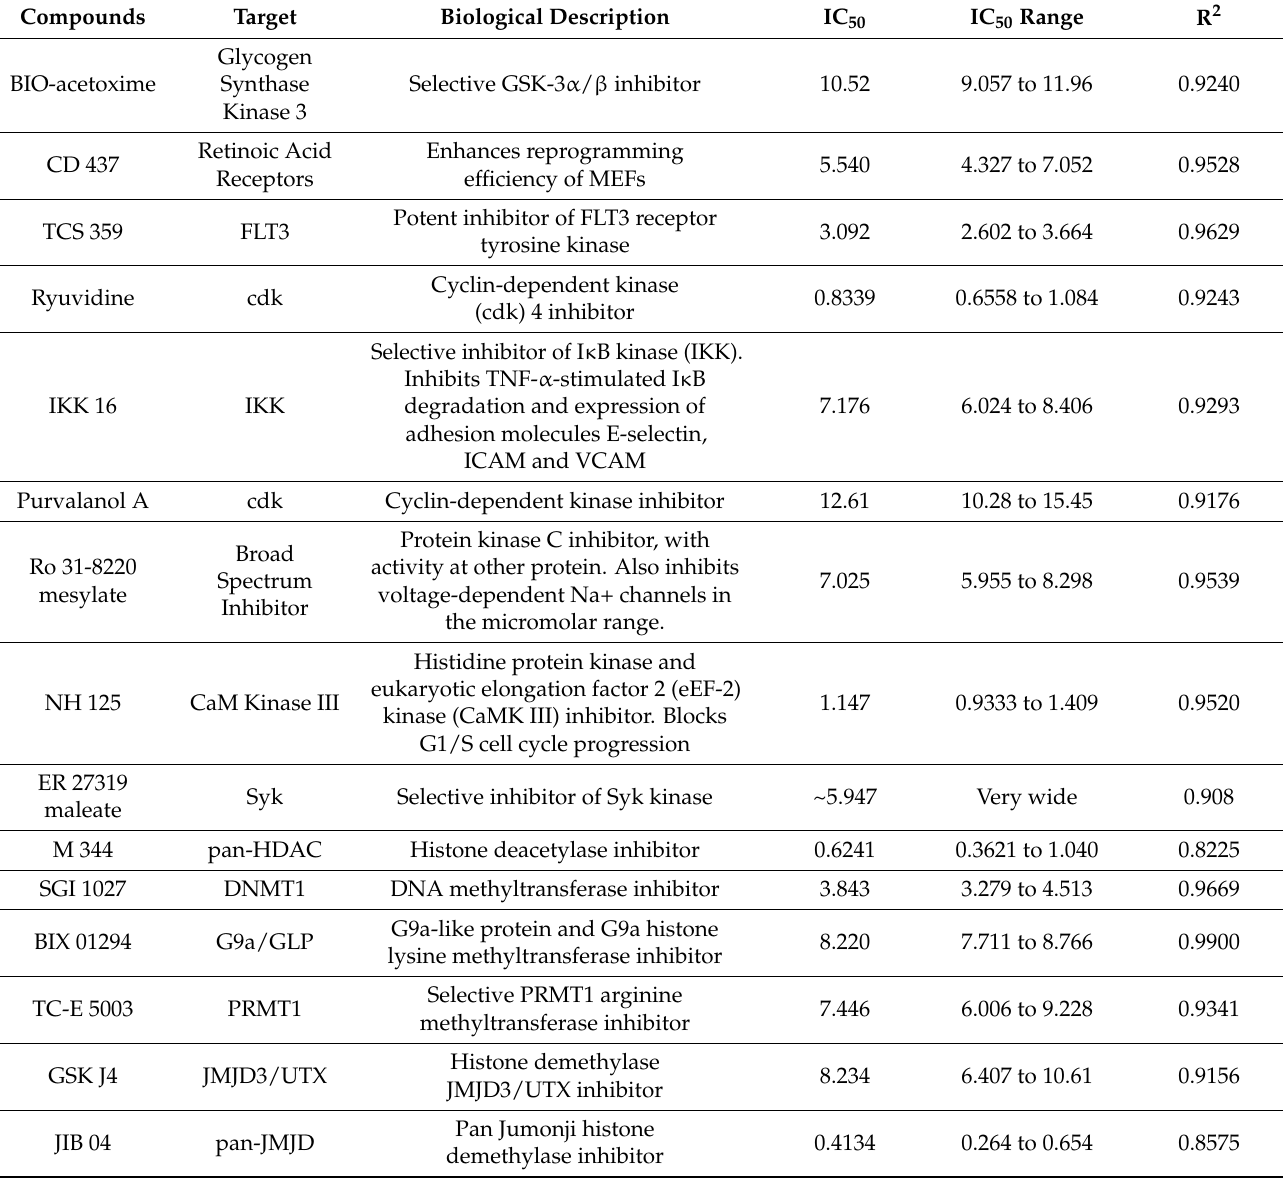
Table 2. IC 50 values of selected cytostatic stem cell modulators, kinase inhibitors, and epigenetic regulators on the KAIMRC2 cell line. All these compounds showed IC 50 values lower than 10 µ M. TCS 359, Ryuvidine (a derivative of benzothiazoledione), NH125, M344, SGI 1027, a Quinoline-based DNA Methyltransferase Inhibitor and JIB04 showed IC 50 values even lower than 5 µ